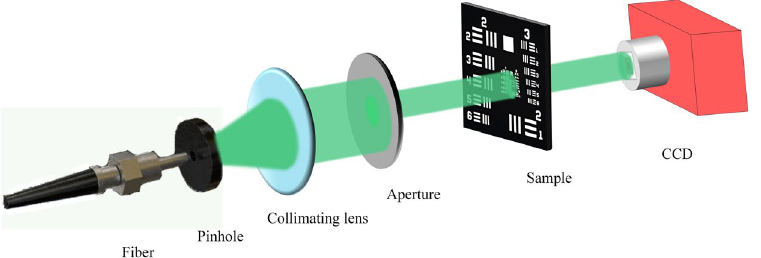
Figure 4. Experiment setup. A green fiber laser at the wavelength of 532 nm passes through pinhole and collimating lens to generate a plane wave. The plane wave shaped by aperture is used to illuminate the resolution chart to form a series of diffraction patterns with the initial distance Z 0 and interval d